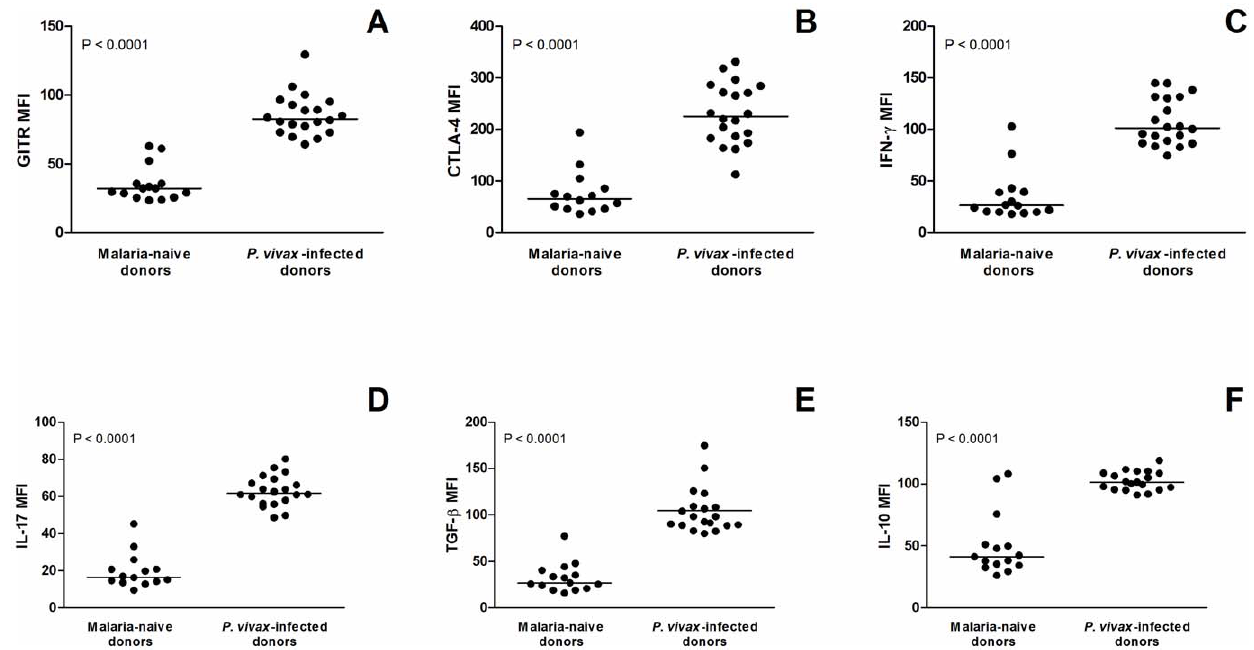
Figure 3. Expression of surface markers (CTLA-4 and GITR) and cytokines (IFN- c , IL-17, TGF- b , and IL-10) on CD4 + CD25 + FoxP3 + regulatory T cells in malaria-naı¨ve and P.vivax -infected donors (n=15 and 20, respectively). Results were expressed as median intensity of fluorescence (lines represent median) for (A) GITR, (B) CTLA-4, (C) IFN- c , (D) IL-17, (E) TGF- b , and (F) IL-10 on CD4 + CD25 + FoxP3 + cells. Statistical differences were detected using Mann-Whitney U test and are indicated on the graphs with significant P values.